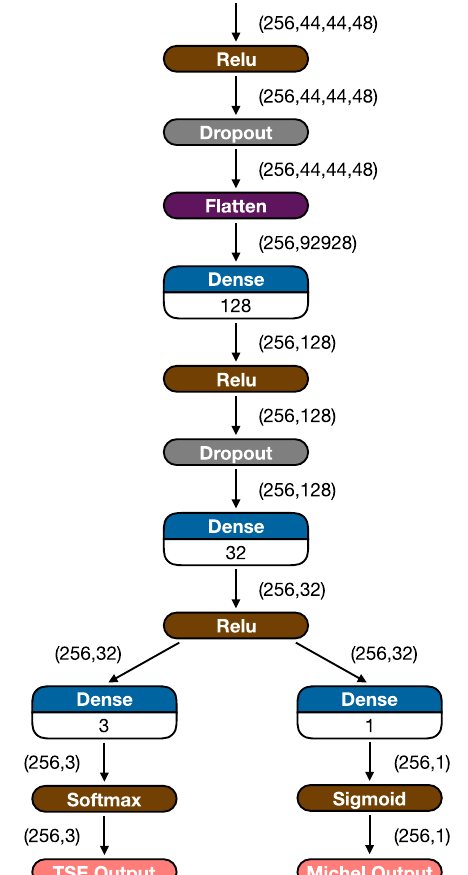
Fig. 3 The CNN architecture. In this case, the CNN processes 256 images in parallel. Each image is a 48 × 48 pixel patch of the calibrated detector readout. A single convolutional layer, with 48 filters of size 5 × 5,isusedtoextractfeaturesfromtheimages.Theseareprocessedbytwo dense layers containing 128 and 32 neurons respectively, before being split into two branches which provide the track-shower-empty (TSE) and Michel outputs. The dimensions of the data after each operation are given next to the black